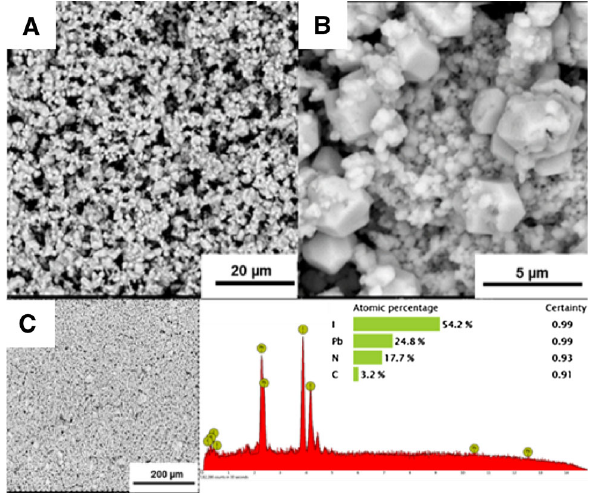
Fig. 4 SEM images and EDX spectrum of the fresh perovskite film, a at 20 l m scale, and b at 5 l m scale, and c EDX spectrum acquired by overview scanning of image c , scale bar is 200 l m